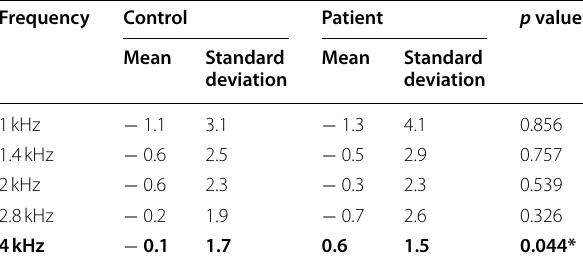
Table 4 Mean contralateral suppression with transient otoacoustic emissions in the